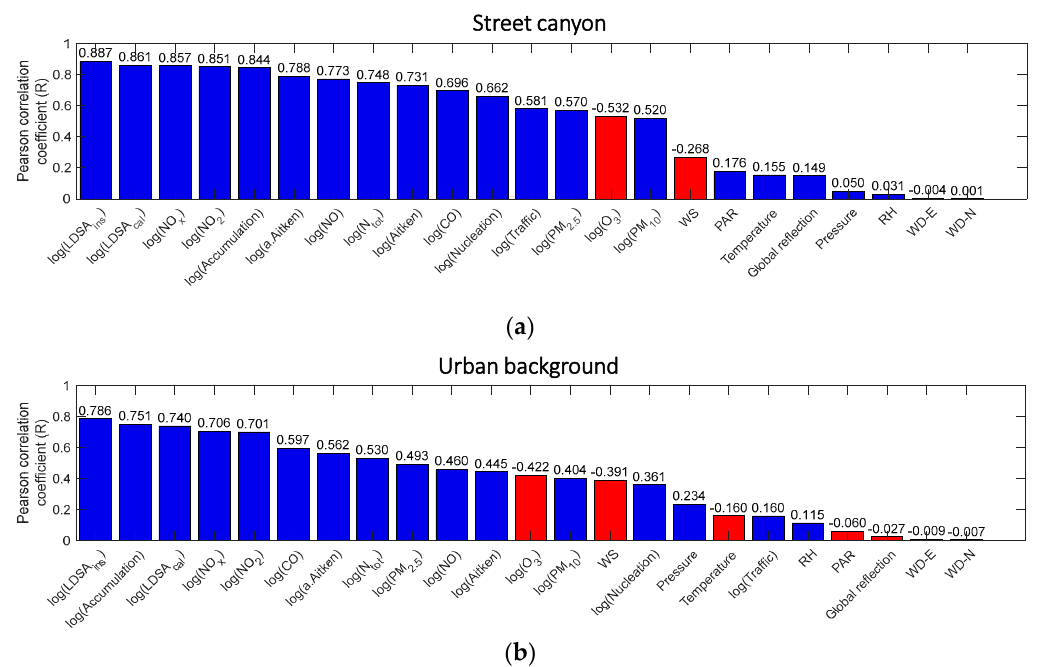
Figure 6. Bar charts showing the overall Pearson coefficient coefficients of logarithm of BC with other variables without any classification. The variables are arranged in descending order of the absolute value of R. Numeric R scores are presented on top of each bar. Negative R scores are illustrated by the red color bars. ( a , b ) show the data in street canyon in Mäkelänkatu and in urban background in Kumpula, respectively.